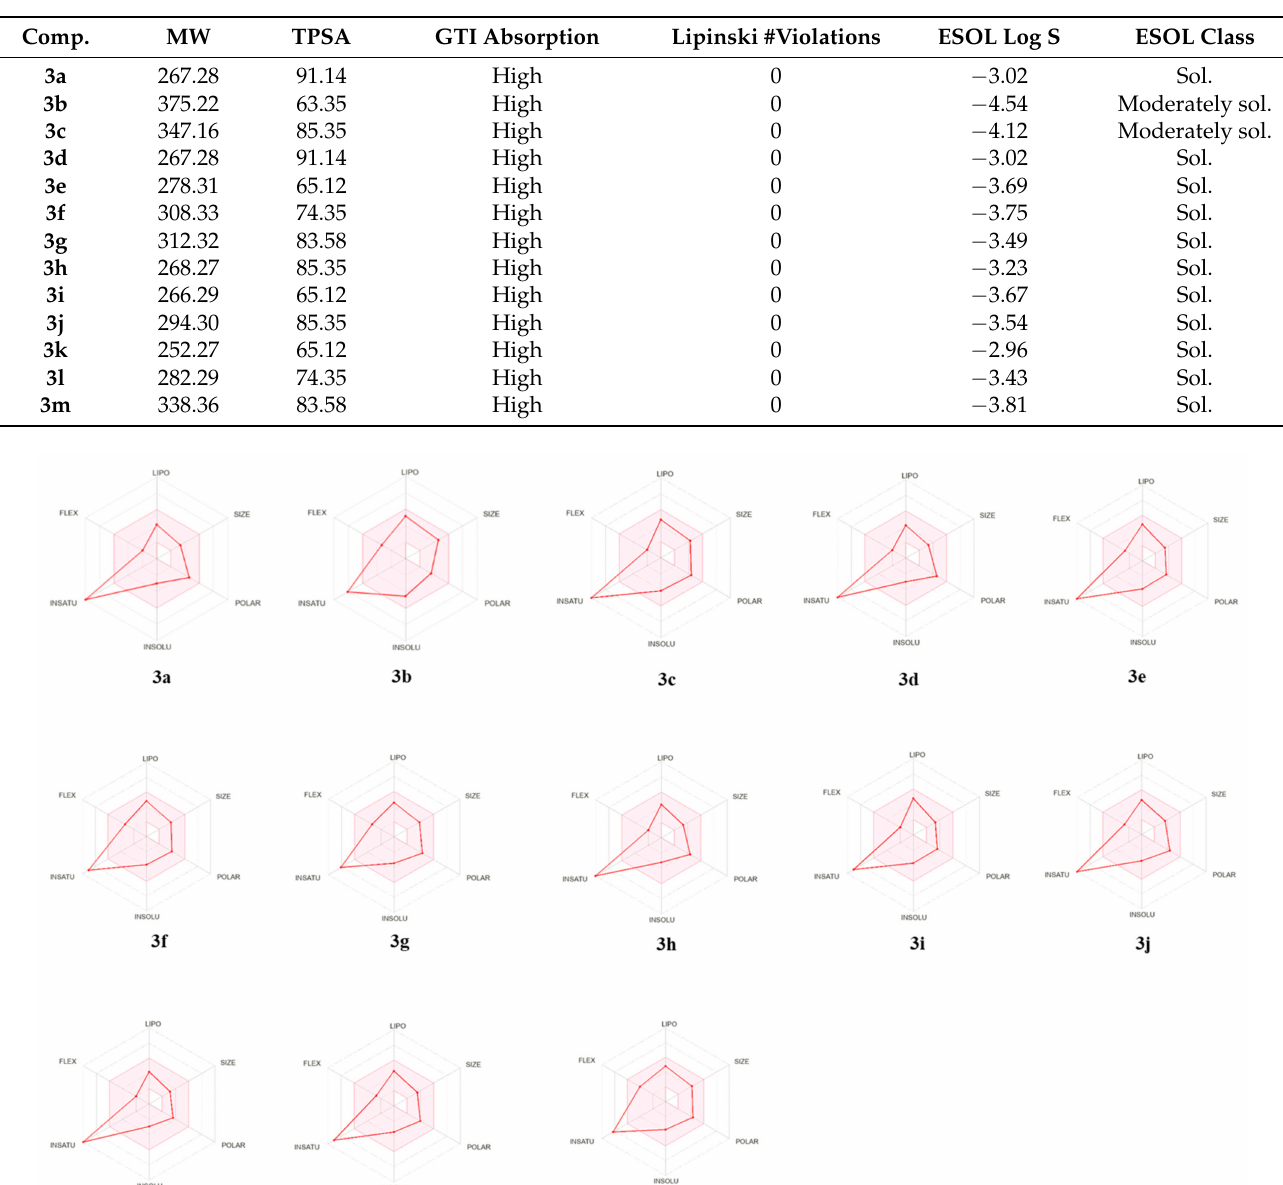
Table 2. Predicted lipophilicity, physicochemical, solubility (sol.), and drug-likeness properties of the